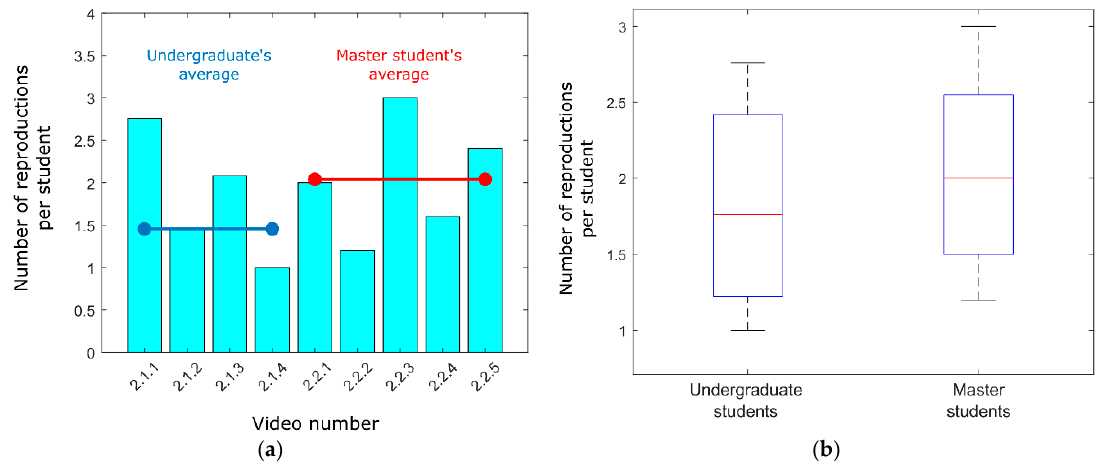
Figure 1. Metrics of views per student ( a ) Bar graph representing the number of reproductions per student for each video (denoted as in Material and Methods section); in blue, the mean value of views/student for undergraduates, and in red, the average for master students. ( b ) Box plot describing the distribution of views/students divided by